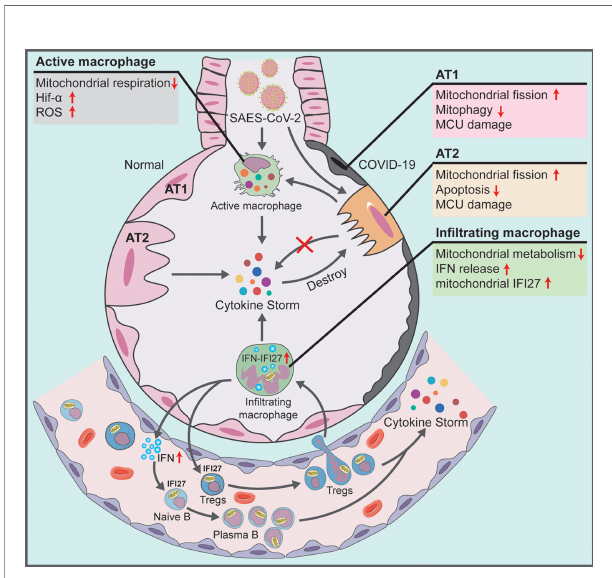
FIGURE 7 | Schematic showing the systemic pathological changes in the lung and blood specimens of patients with